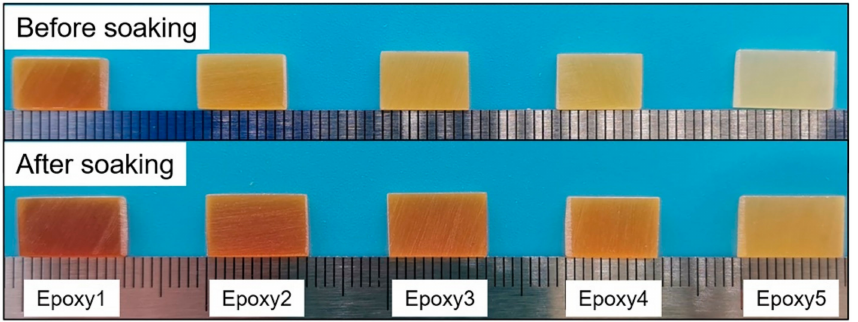
Figure 8. The appearance of epoxy resins with different crosslink densities before and after being soaked in TCB at 180 ◦ C for 12 h. Table 4. The mass changes of epoxy resins after being immersed in organic solvents and